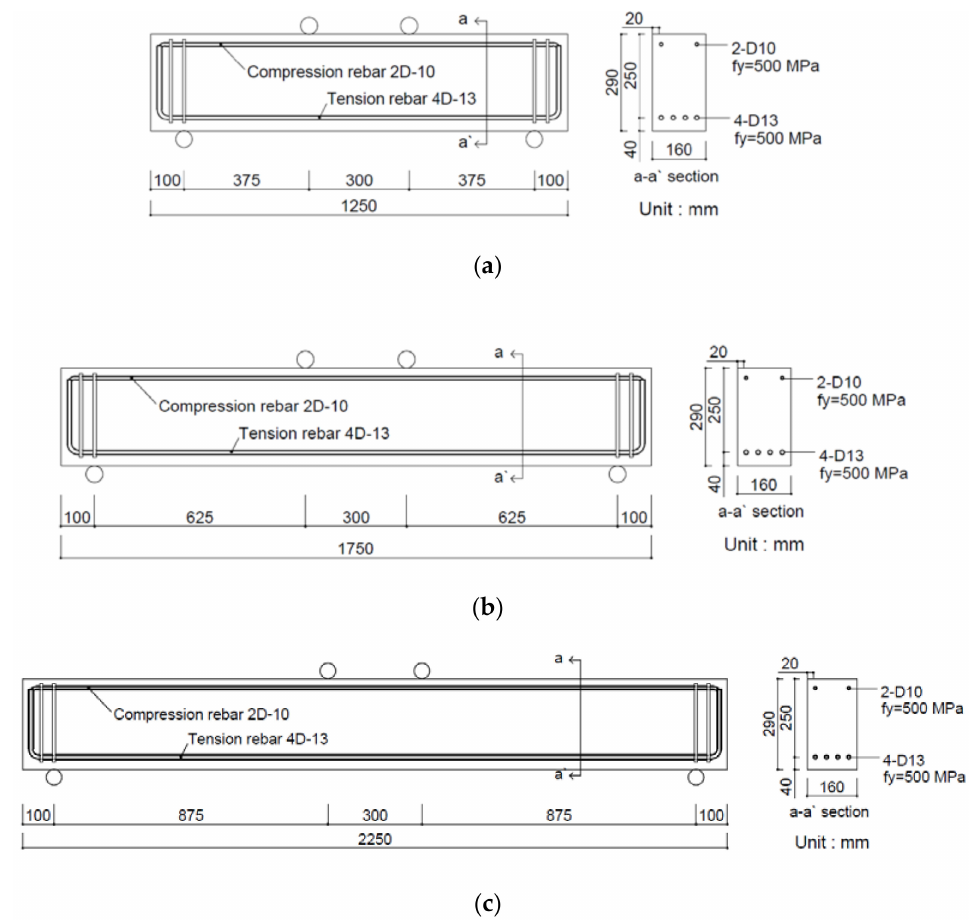
Figure 1. Details of steel fiber-reinforced concrete test beams according to shear span-to-depth ratio ( a/d ). ( a ) a/d = 1.5. ( b ) a/d = 2.5. ( c ) a/d = 3.5.